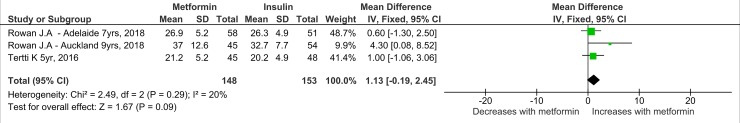
Childhood weight.Expressed as mean differences (fixed effects model) and 95% CI. IV, mean difference.